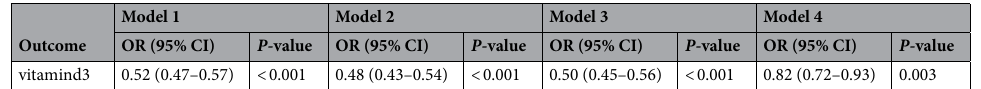
Table 3. The association between Vit D3 and insulin resistance in a multiple regression model. Model 1: No adjustments have been made; Model 2: Adjustments were made for gender, age and race; Model 3: Adjusted for model 2, smoking, alcohol consumption, income, and education level were added; Model: HDL, UCR, ALB, WAIST, ALT, AST, BUN, TC, GGT, UA, TBIL, LDH were added on the basis of model